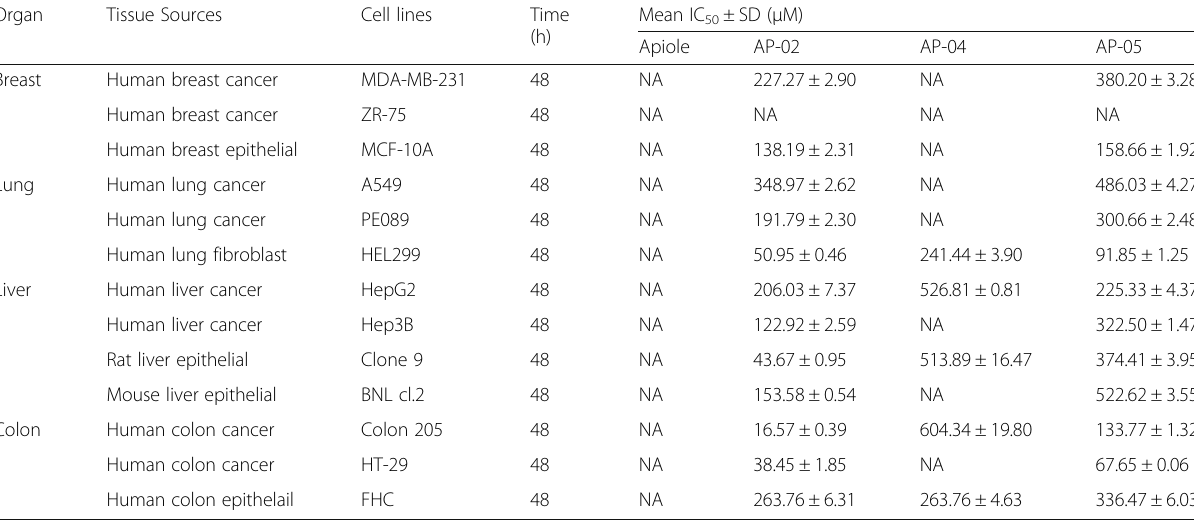
Table 1 Cytotoxic effects of Apiole derivatives (AP-02, 04, 05) upon various human breast (MDA-MB-231, ZR75), lung (A549, PE089), liver (Hep G2, Hep 3B), and colon (COLO 205, HT 29) cancer cells Organ Tissue Sources